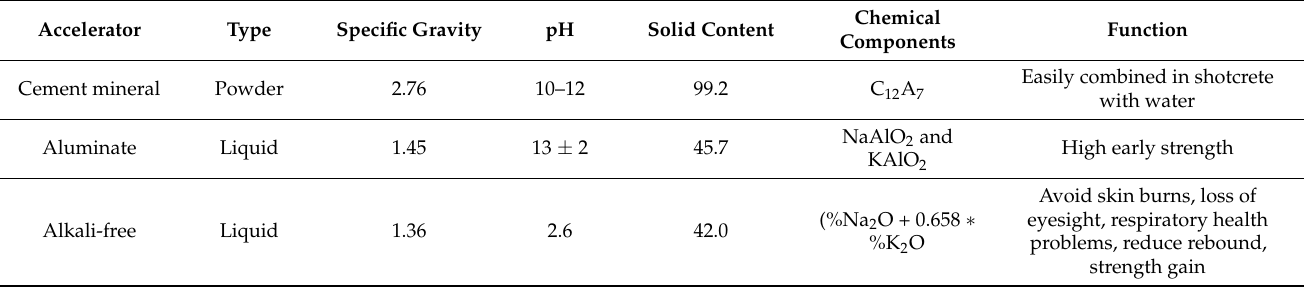
Table 2. Physical properties of the accelerators.